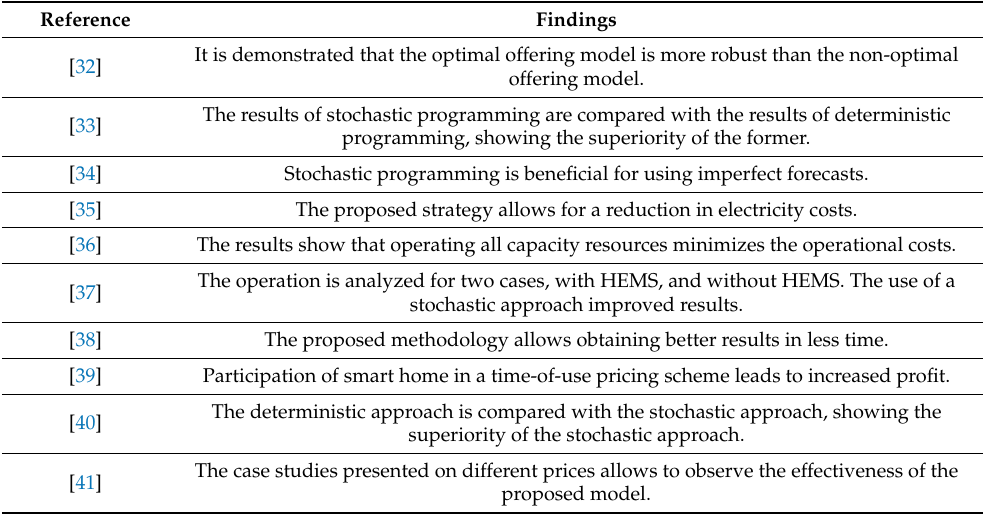
Table 11. Findings of selected papers associated with stochastic programming.